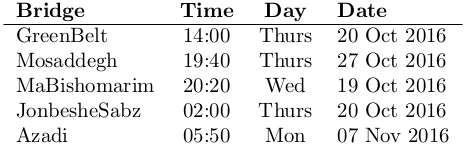
Table from the paper: Detecting Censor Detection
Table text:
Bridge
Time
Day
Date
GreenBelt
14:00
Thurs
20Oct2016
Mosaddegh
19:40
Thurs
27Oct2016
MaBishomarim
20:20
Wed
19Oct2016
JonbesheSabz
02:00
Thurs
20Oct2016
Azadi
05:50
Mon
07Nov2016